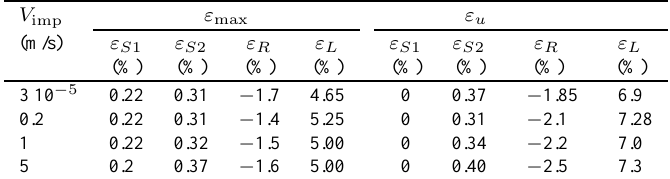
Table 3 Local results of the quasi-static and dynamic tension tests